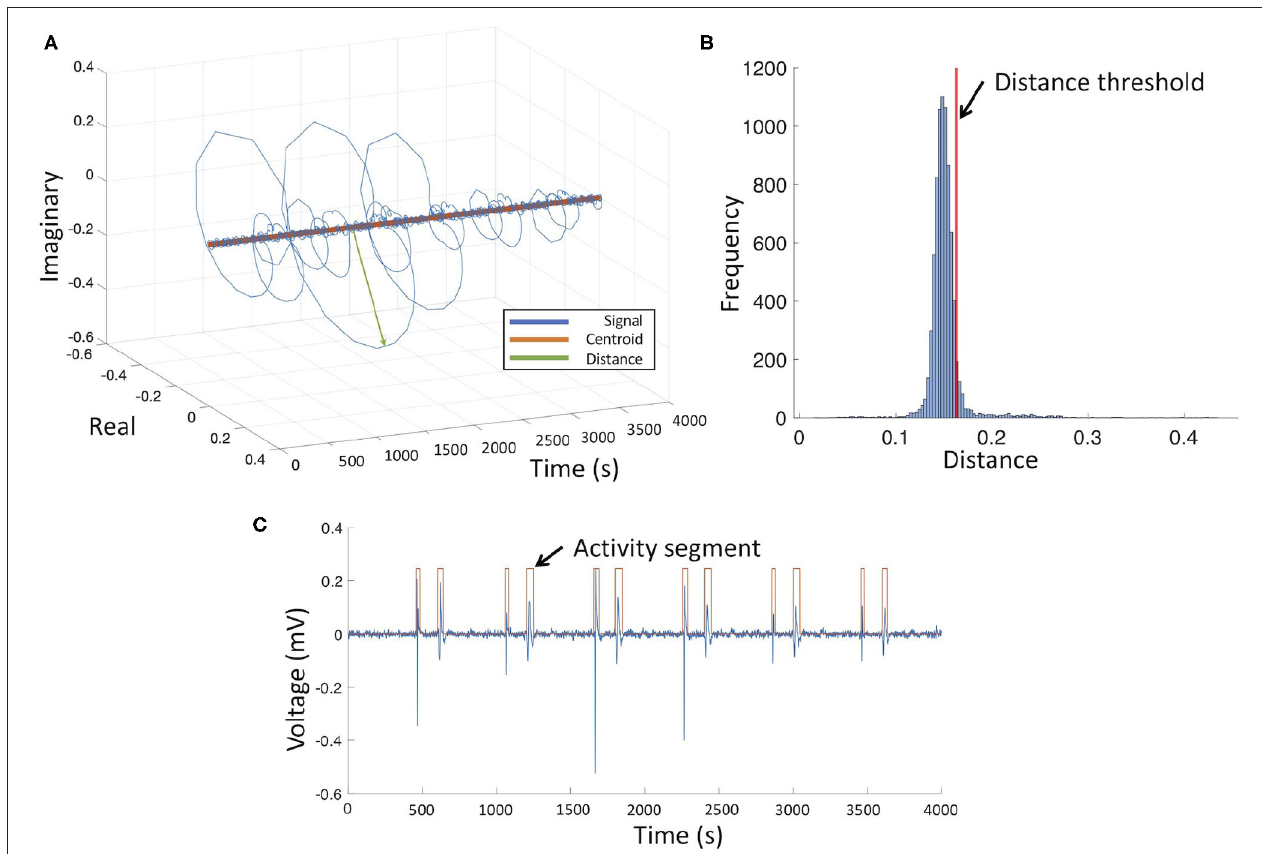
FIGURE 3 | Electrogram activity detection in the Hilbert space. (A) Electrogram signal (C) in the Hilbert Space with centroid (orange trace), green arrow depicts the distance measured from the centroid to the signal. (B) Frequency distribution of centroid to signal distance, red line represents mean value plus one standard deviation. (C) Bipolar electrogram (blue trace) and activity segments (orange